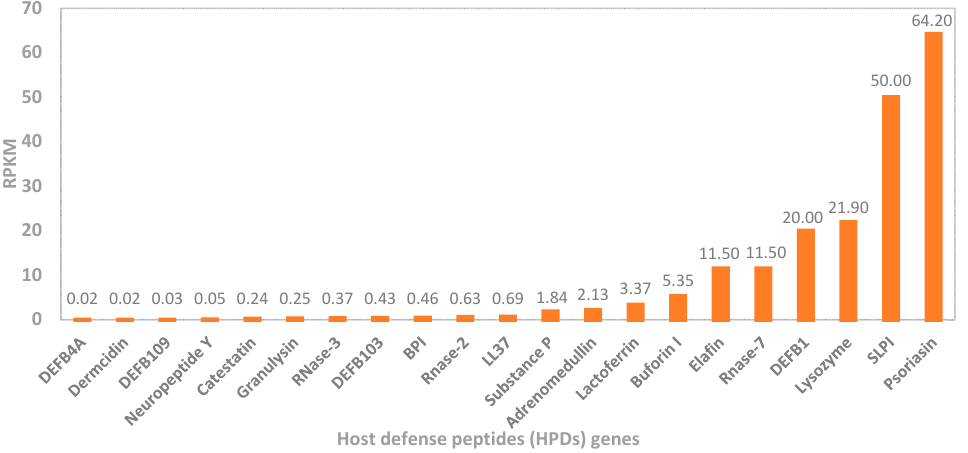
Figure 4. Relative expression of selected host defense peptide (HDP) genes in the human skin, based on RNA-seq analysis of tissue samples from 95 human individuals performed by Fagerberg et al. [107]. The data were obtained from the GenBank Bio Project: PRJEB4337 (RPKM, reads per kilobase per million reads).